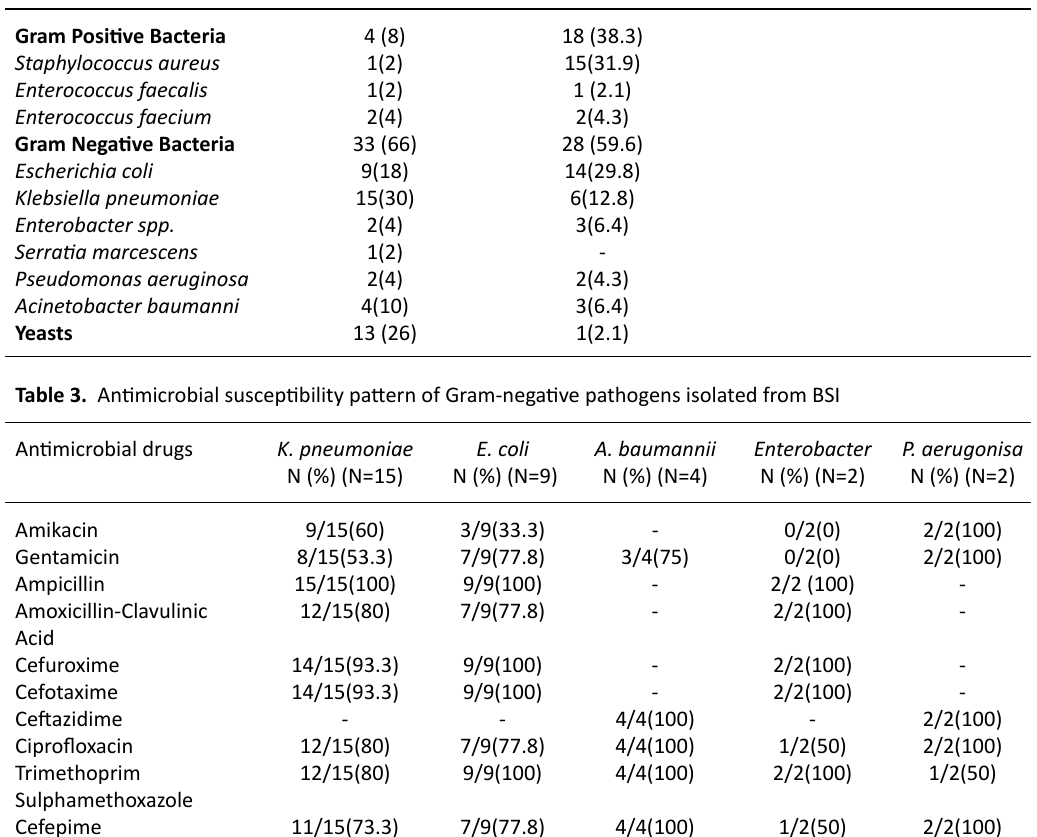
Table 2. Microbial profile of BSI Organisms Isolated